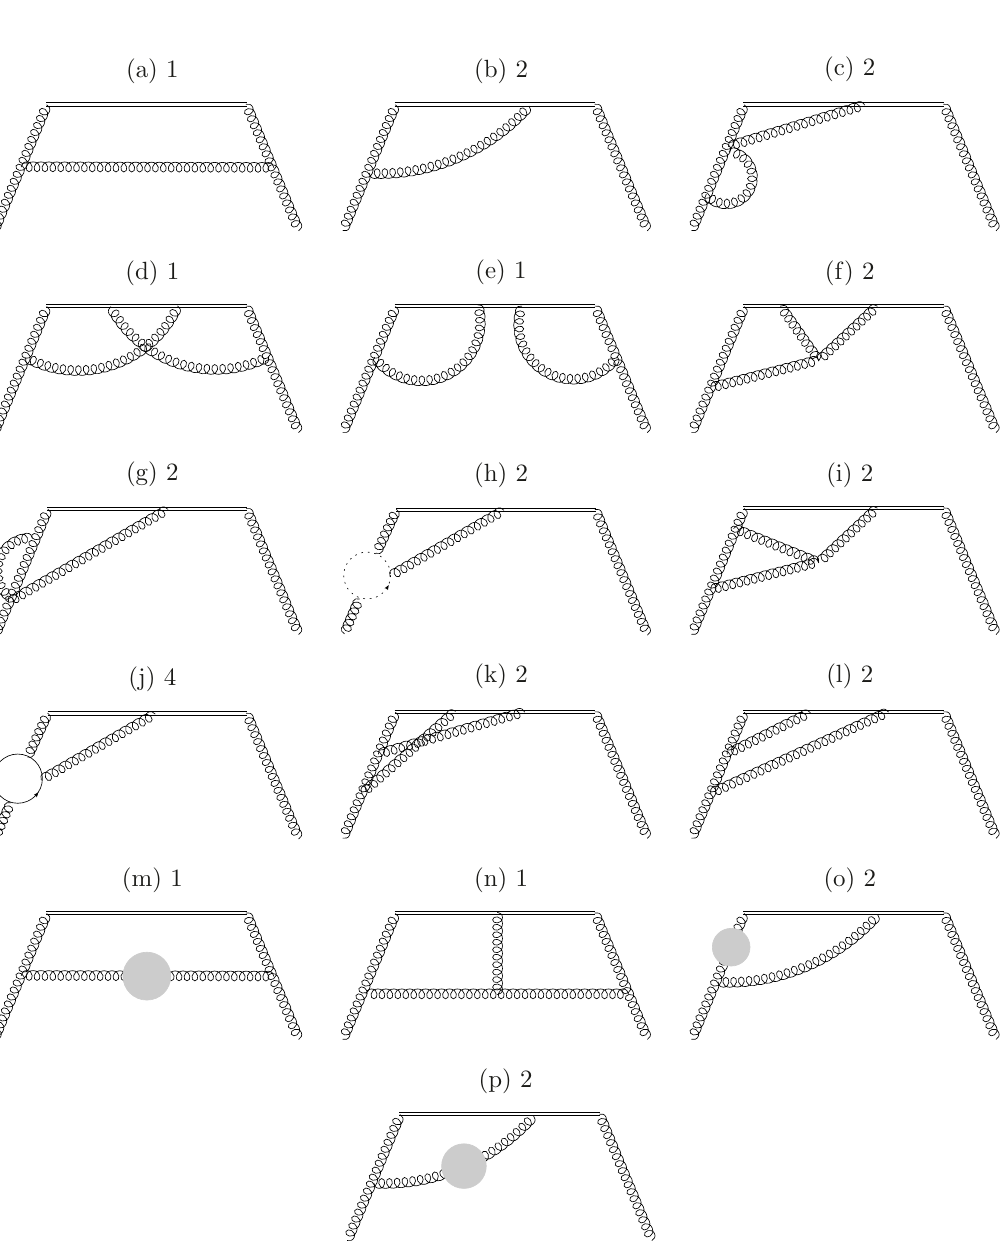
Figure 5. Large- x divergent contributions to the gluon-gluon parton distribution up to two loops. The grey blob represents a self energy insertion. Insertions on external legs are excluded. The clockwise ghost is included in